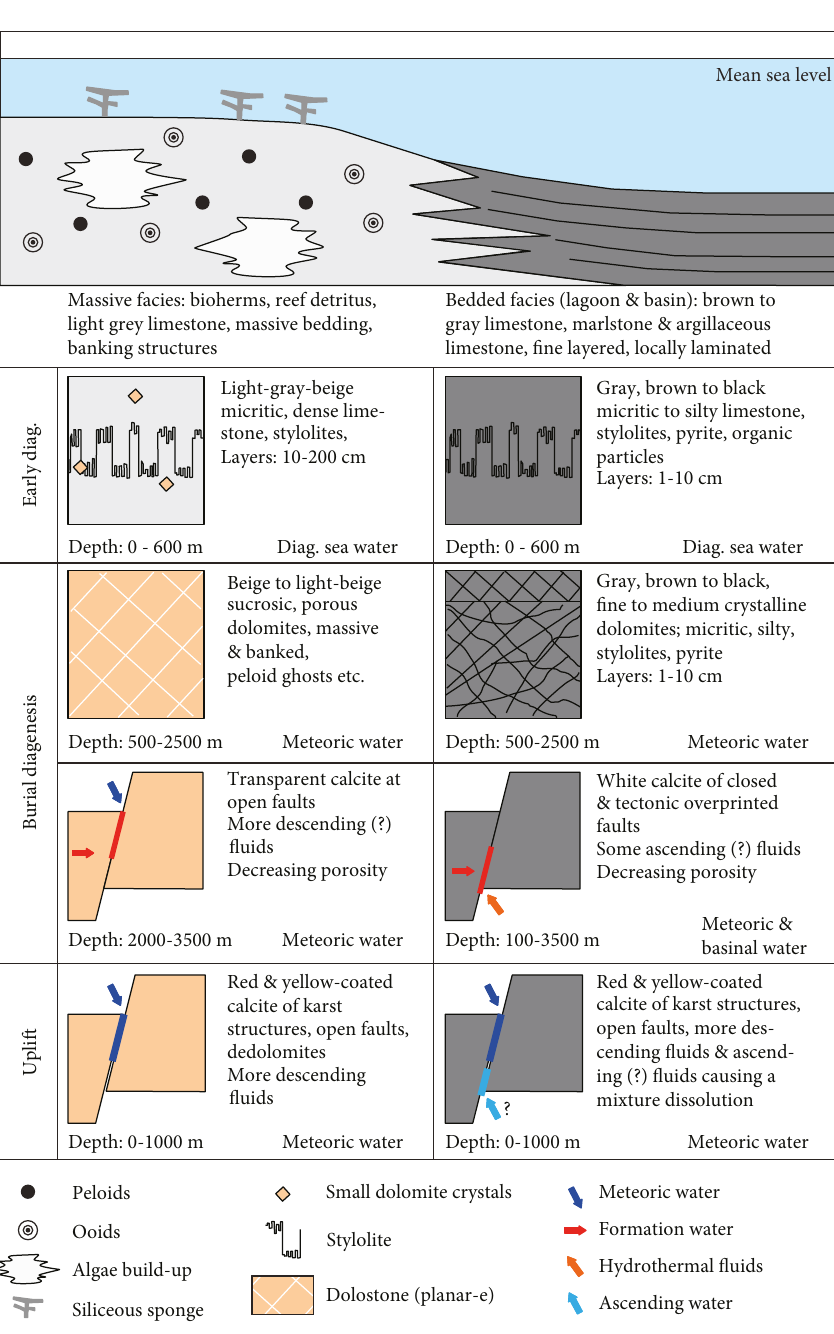
Figure 4: Schematic burial history of Upper Jurassic carbonates of the Molasse Basin [17,